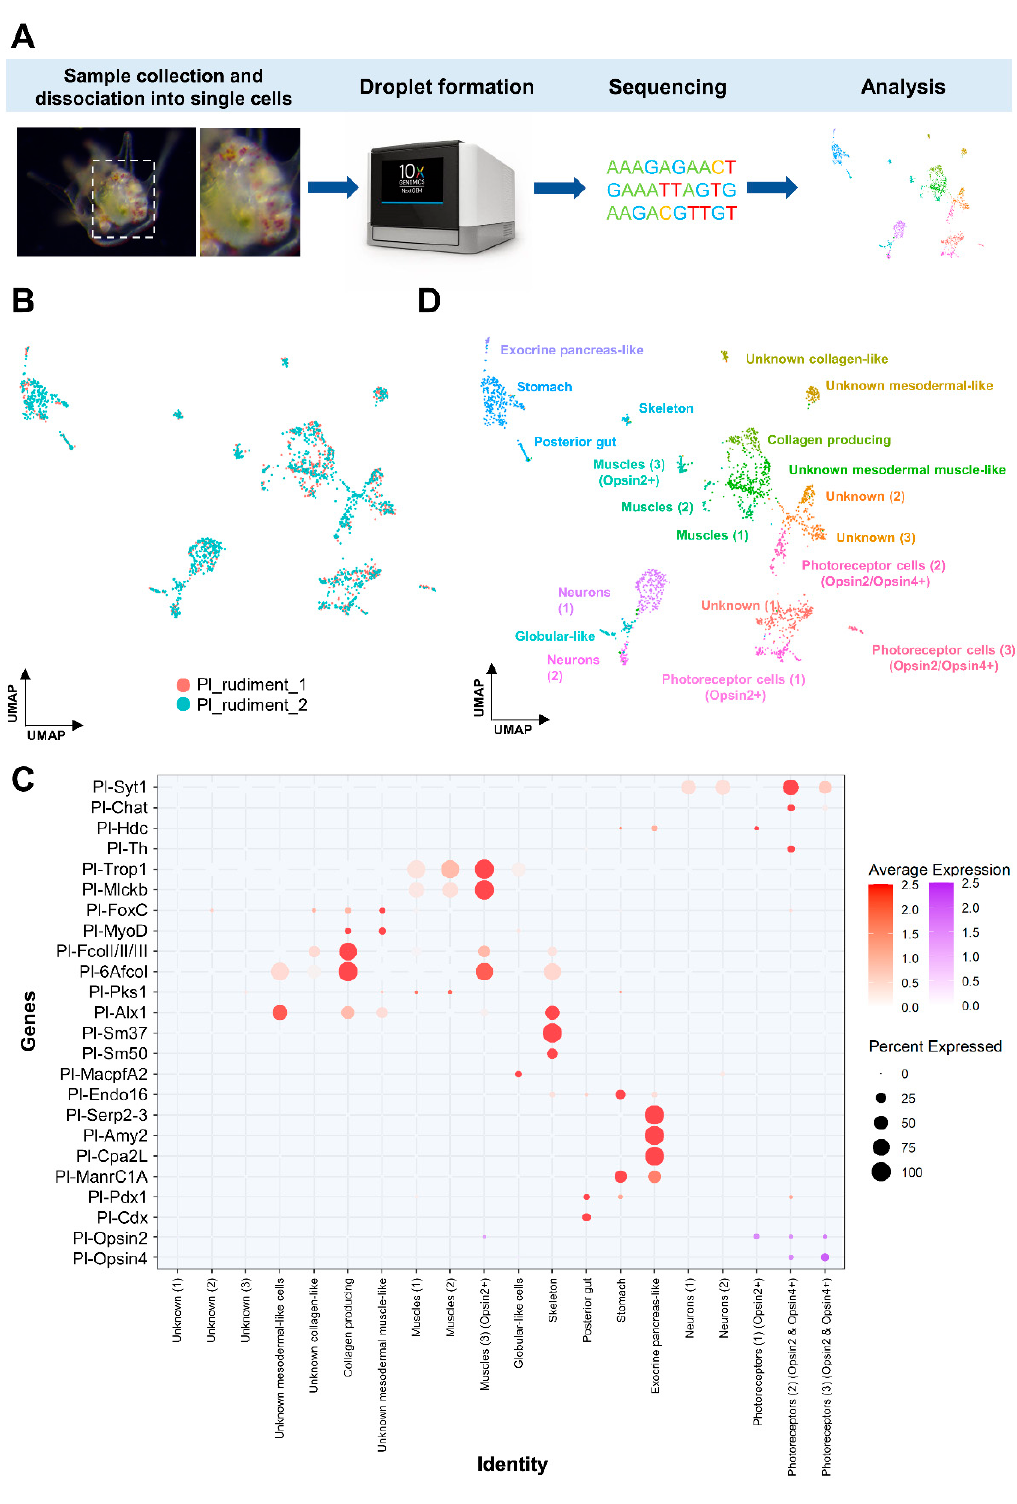
Figure 1. Cell type atlas of the P. lividus mature rudiment. ( A ) ScRNA-seq pipeline from larvae collection, rudiment dissection and dissociation to 10× capturing and computational analysis. ( B ) Overlay UMAP showing the overlap of the libraries originating from the two biological replicates. ( C ) Dotplot showing the average expression of genes used as markers to identify specific cell clusters. ( D ) UMAP showing mature rudiment cell types, colored by their assignment to the initial set of 20 distinct cell clusters. Average expression gradient for opsin genes is depicted in purple, and for the rest of the genes, in red.